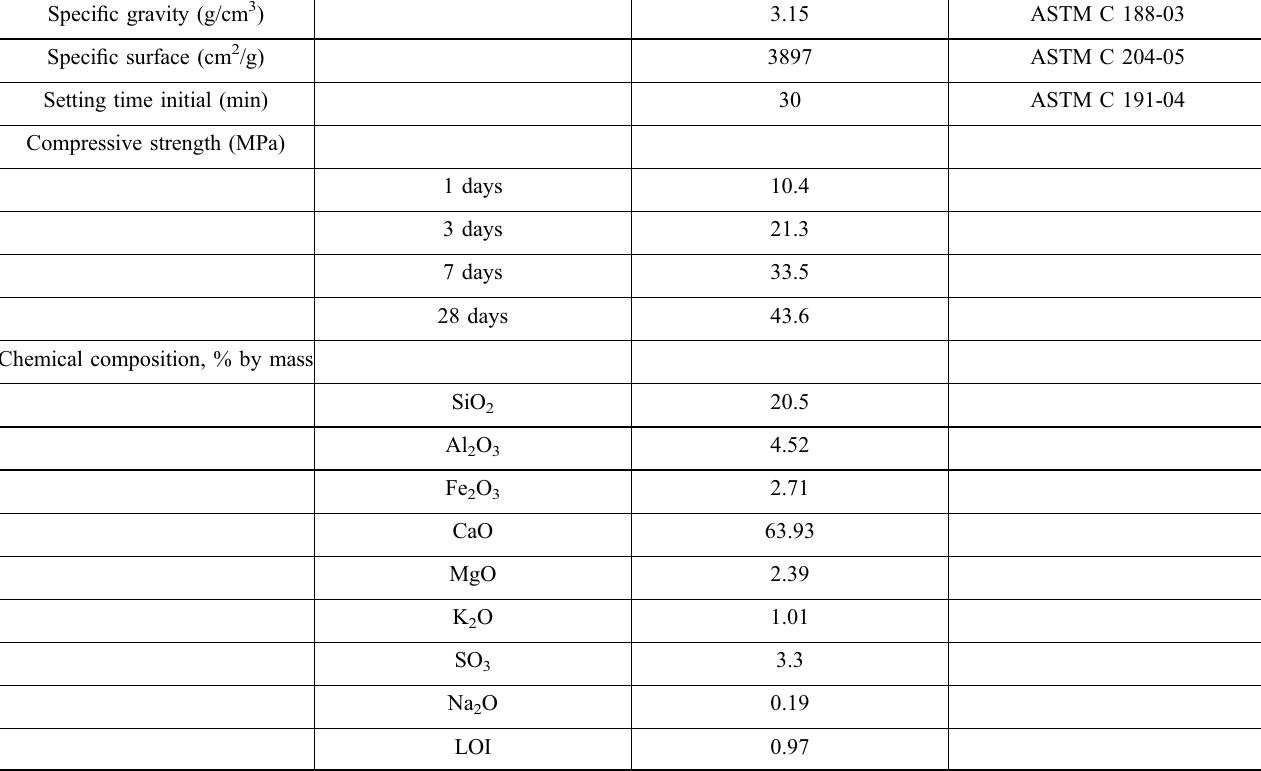
Table 1 Physical and chemical properties of